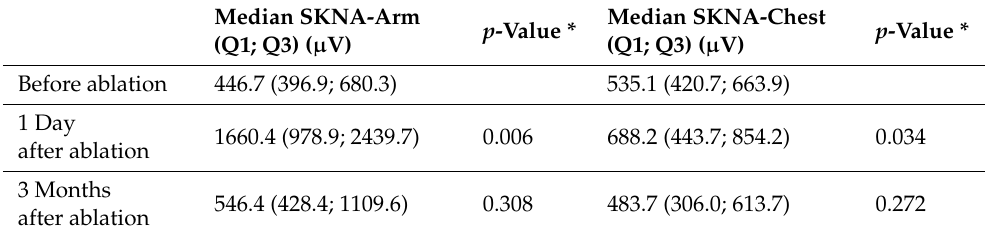
Table 4. Comparisons of mean SKNA among before, 1 day, and 3 months after the ablation ( n = 12).